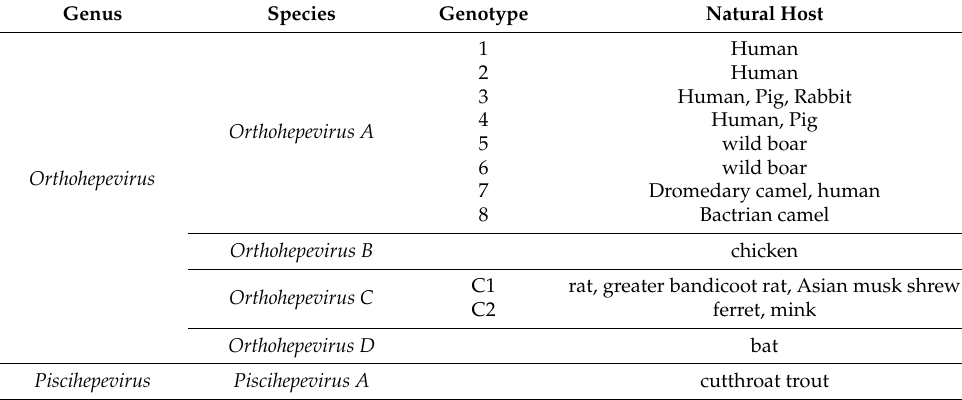
Table 1. Classification of the Hepeviridae